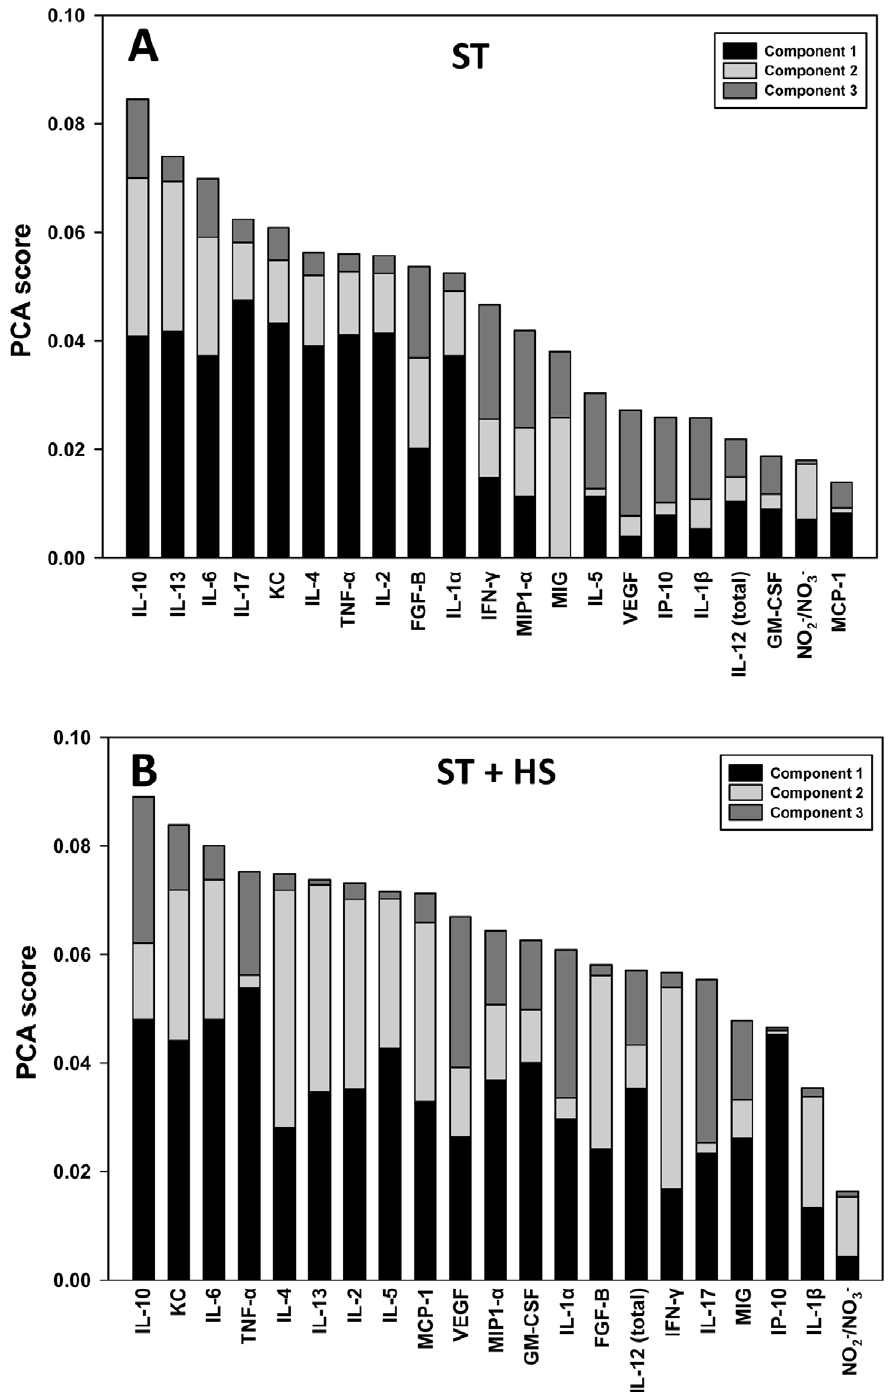
Figure 4. Principal Component Analysis of circulating inflammatory mediators induced by ST 6 HS. Mice were subjected to ST 6 HS followed by measurement of cytokines, chemokines, and NO 2 2 /NO 3 2 as described in the Materials and Methods . The figure shows the sorted overall PCA score for each inflammatory mediator. doi:10.1371/journal.pone.0019424.g004 means that IL-12.total grows linearly only (not quadratically) with time, and that this linear time growth depends on the Procedure (explaining the existing interaction). A comparison of the actual Total IL-12 data to the fitted value produced by this model is found in the Fig. S2A.